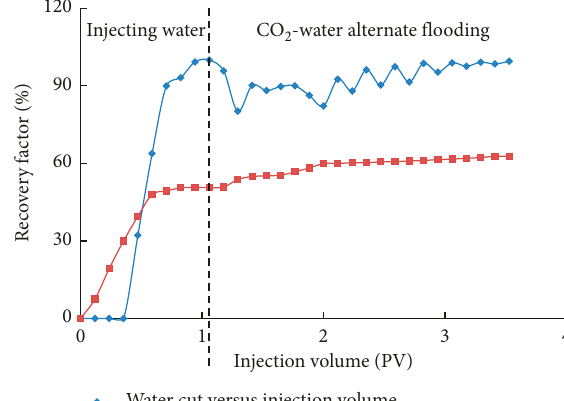
2 -water alternate